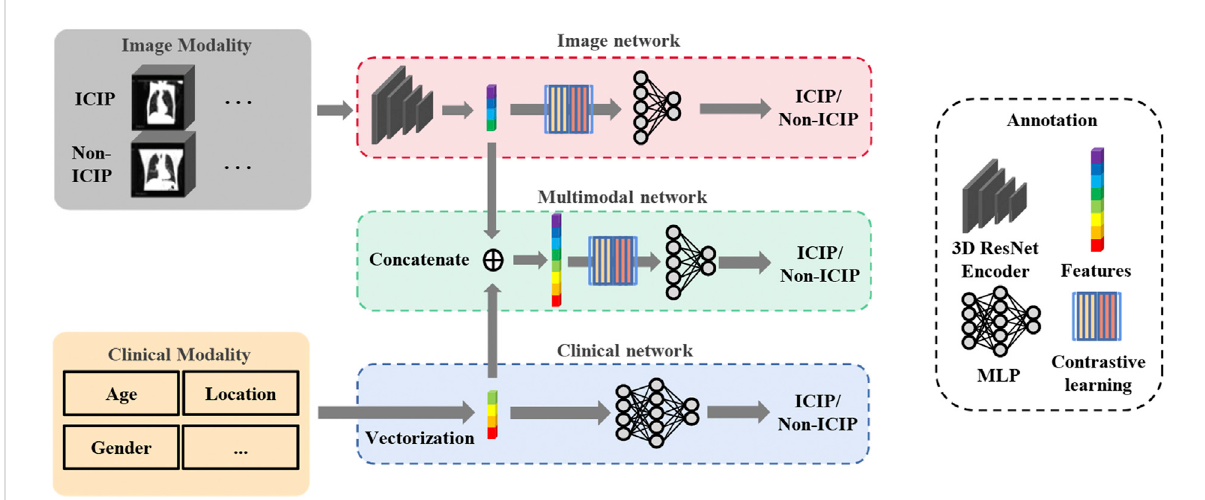
FIGURE 2 Overview of the network architecture for ICIP prediction. The top and bottom boxes show the image network and clinical network using CT images and clinical data, respectively, as input. The middle box represents the multimodal fusion network that combines image features and clinical features for ICIP prediction.